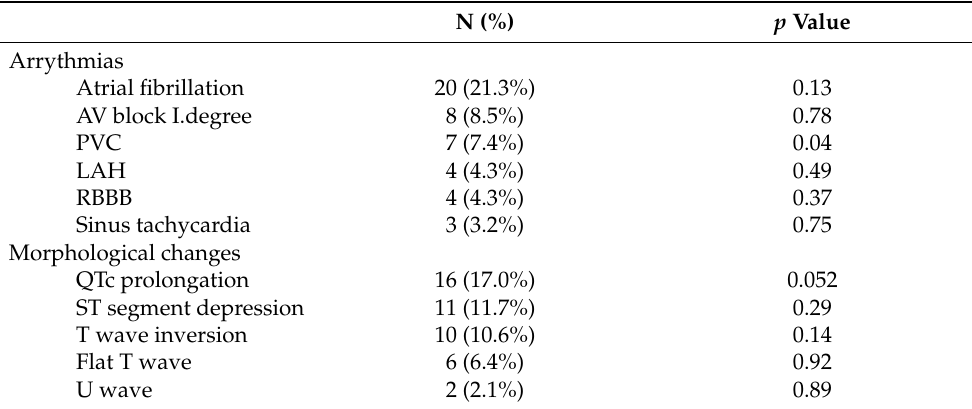
Table 2. Relationship between lower TRAIL levels and ECG changes in